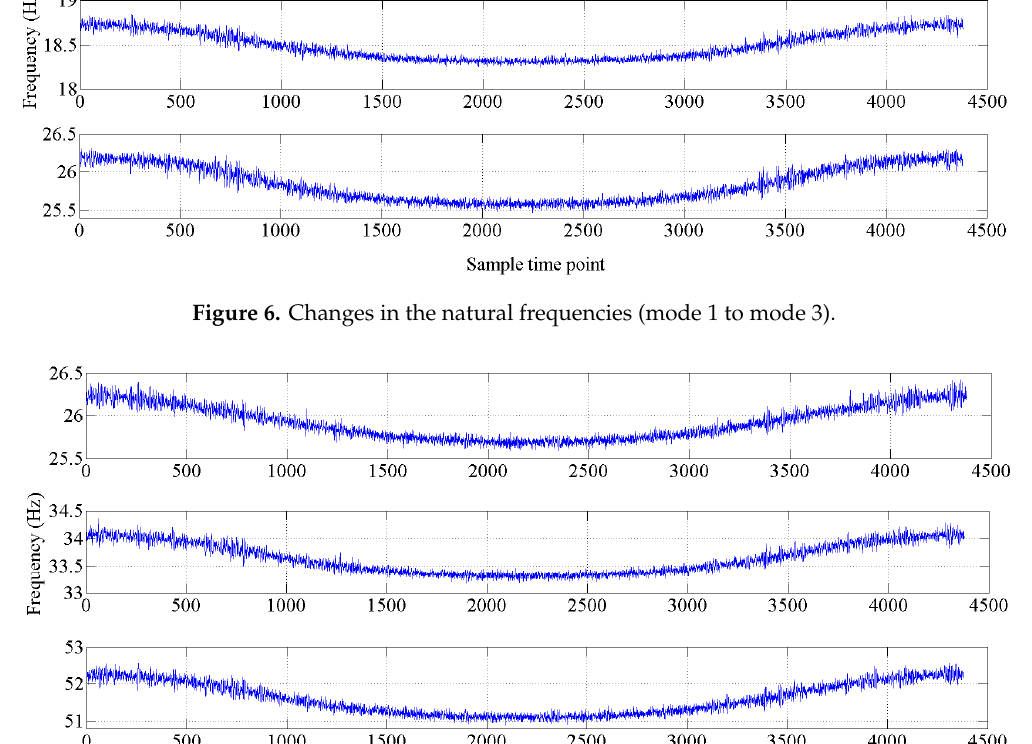
Figure 7. Changes in the natural frequencies (mode 4 to mode 6).